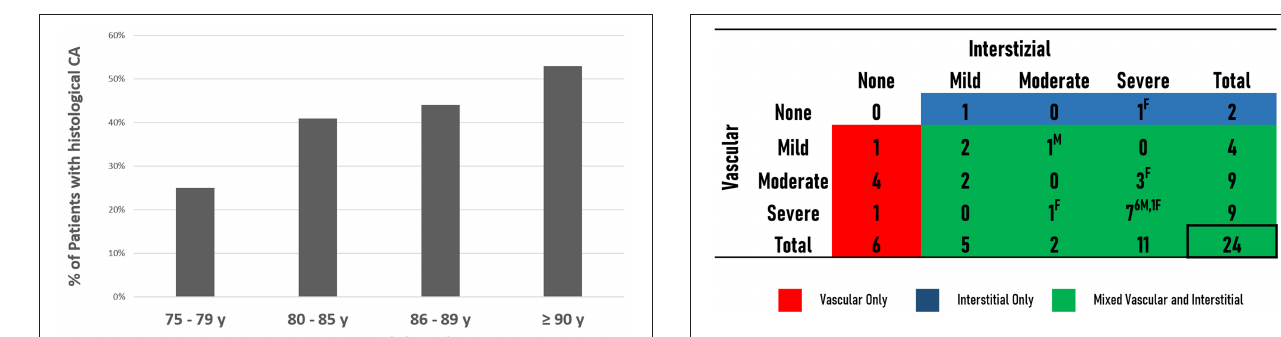
FIGURE 4 | Localization and severity of amyloid deposition in the patients with CA. The number of patients with no (none), mild, moderate or severe interstitial FIGURE 3 | Prevalence of CA (any site) at autopsy according to age at death. and vascular amyloid is shown. Patients with only vascular deposition (red), %, percentage; CA, Cardiac Amyloidosis. only interstitial (blue), or mixed (green) deposition are illustrated. Sex [male (M) or female (F)] of patients with moderate and severe deposition is provided. TABLE 2 | Prevalence, localization, and distribution of amyloid in heart chambers. TABLE 3 | Univariate analysis for the presence of amyloid deposition. Heart Presence of Amyloid Amyloid chamber amyloid localization distribution vascular vs. non-diffuse interstitial vs. diffuse Atria